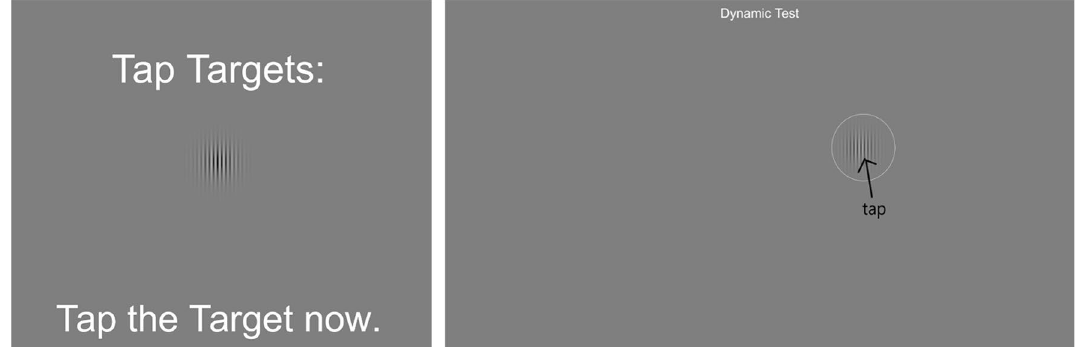
Figure 3. Contrast sensitivity task. Gabors appeared one at a time on the screen against a gray background. Participants were instructed to tap on the patch as quickly as possible. The circle surrounding the Gabor is for illustrational purposes.